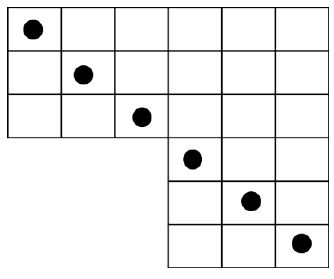
Figure 3 . A simple example for a seperable vacuum in the G = SU(3) 2 theory. The operator getting VEV can be written as a product of two G -invariant operators: a baryon of SU(3) 1 and a baryon of SU(3) 2